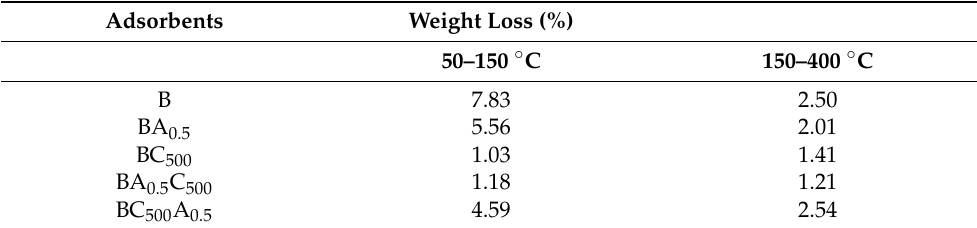
Table 3. Water content (%) in bentonite and modified